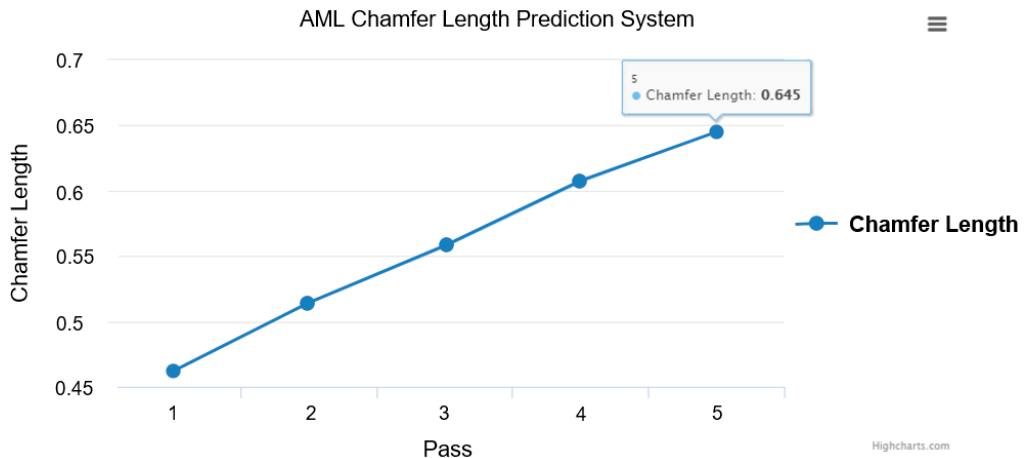
Figure 17. The data visualization of the chamfer length predictions.